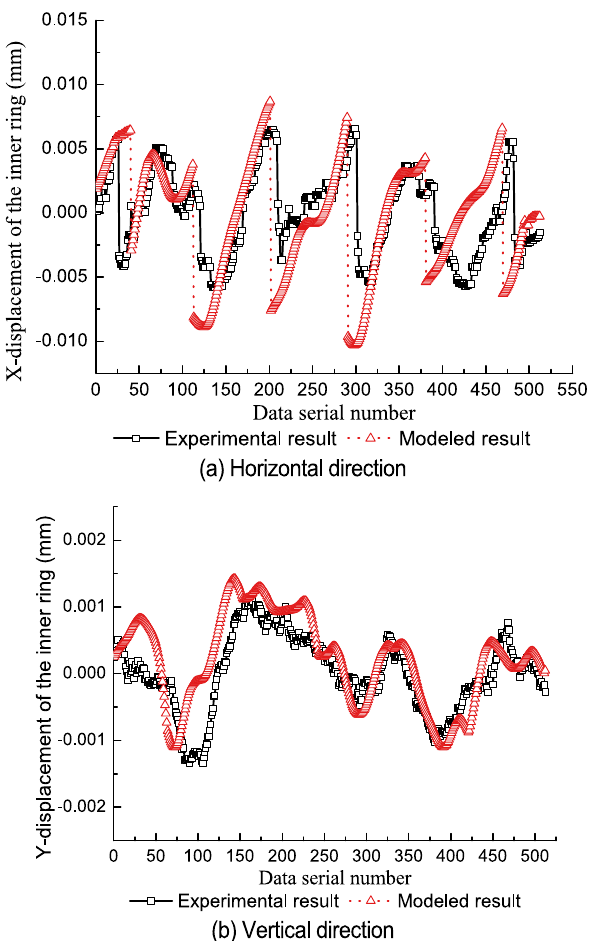
Figure 6. Second test bearing comparison between the experimental results and modeled